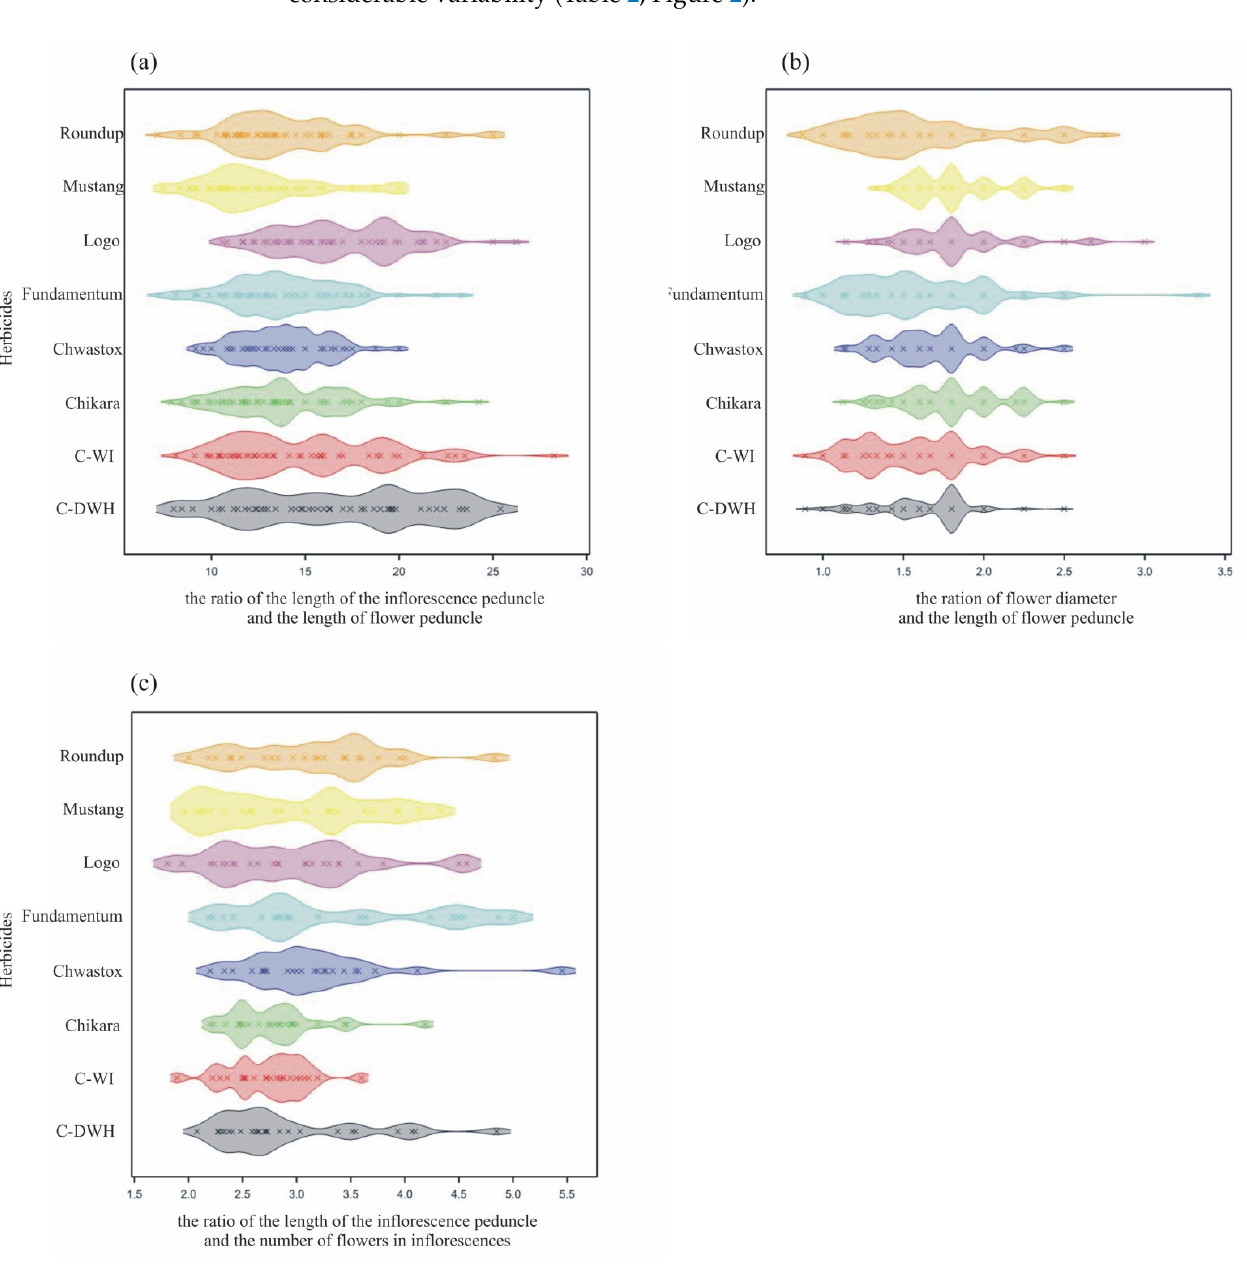
Figure 2. The density plot of ( a ) the ratio of the length of the inflorescence peduncle and the length of flower peduncle, ( b ) the ratio of flower diameter and the length of flower peduncle, ( c ) the ratio of the length of the inflorescence peduncle and the number of flowers in inflorescences by herbicides. The length of the inflorescence peduncle was from several to several dozen times longer than the length of the flower peduncle. Another feature—the FD/LFP ratio (flower diameter to length of its peduncle) was much less variable than the previous one and it